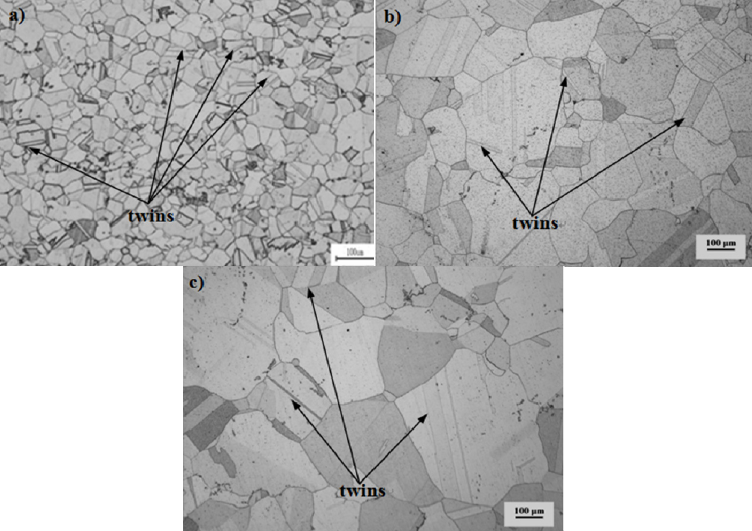
Figure 1. The grain morphology of the nickel-base superalloy. ( a ) the original grain; ( b ) Pro.I; ( c ) Pro.II.